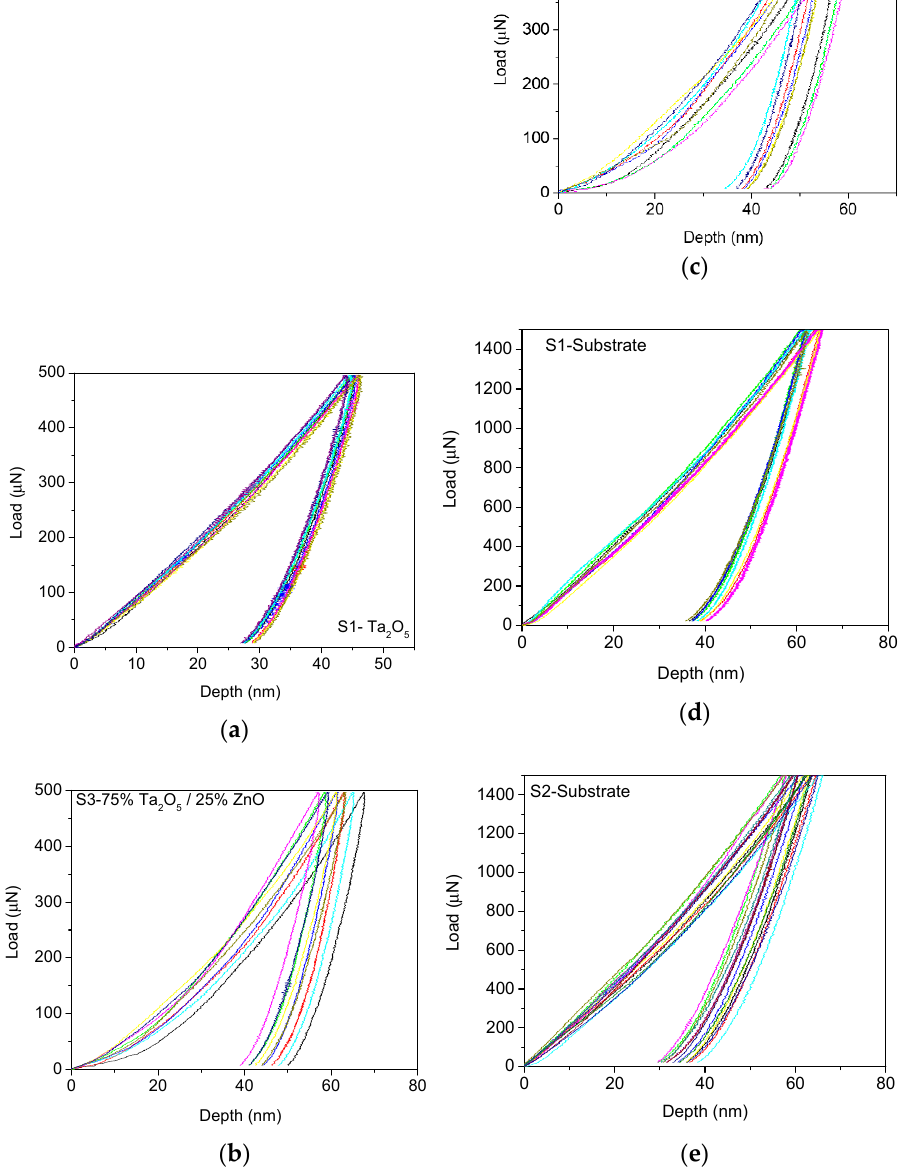
Figure 9. The nanoindentation curves of the coated samples ( a ) S1, ( b ) S3, and ( c ) S5. The nanoinden- tation curves of the Co-Cr base layer for samples ( d ) S1 and ( e ) S2.